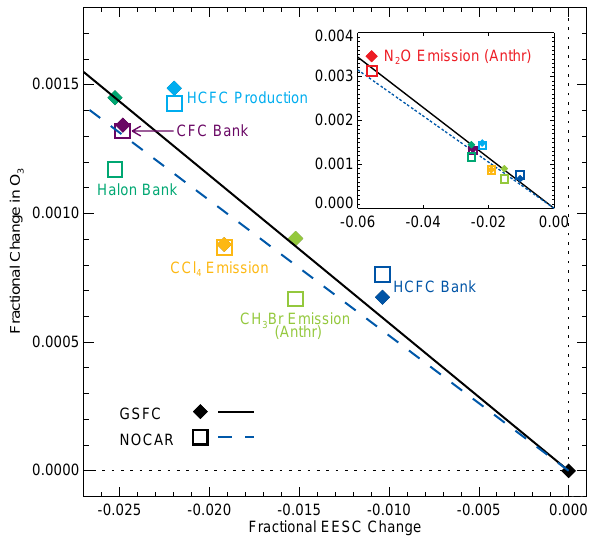
Fig. 6. Impact of the 7 hypothetical emissions reductions shown in Table 1 on integrated EESC (solid bars) and global total column O 3 from GSFC (horizontal hatching) and NOCAR models (angled hatching). Integration periods of (a) 2011–2050 and (b) 2011–2100 are shown. The EESC changes are scaled by the slope of the linear fit to the GSFC calculations (solid black line) shown in Fig. 5. The extent to which ozone bars are the same height as the same-colored EESC bars (in the same panel) quantifies the success of the EESC parameterization in describing the integrated ozone